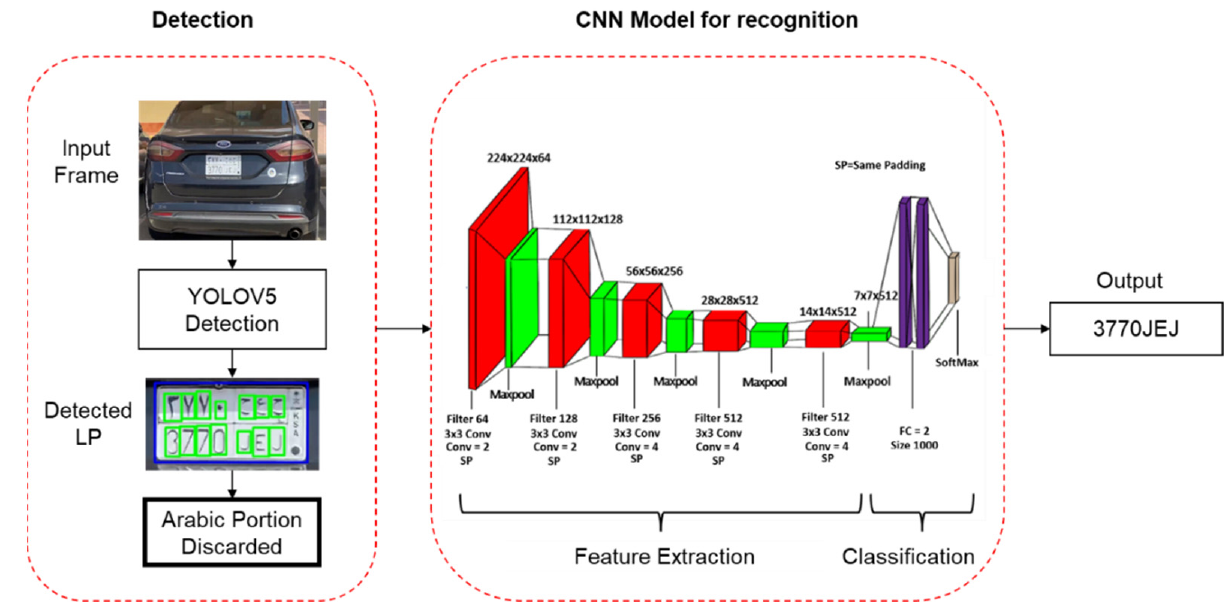
Figure 7. The complete architecture of the proposed pipeline.